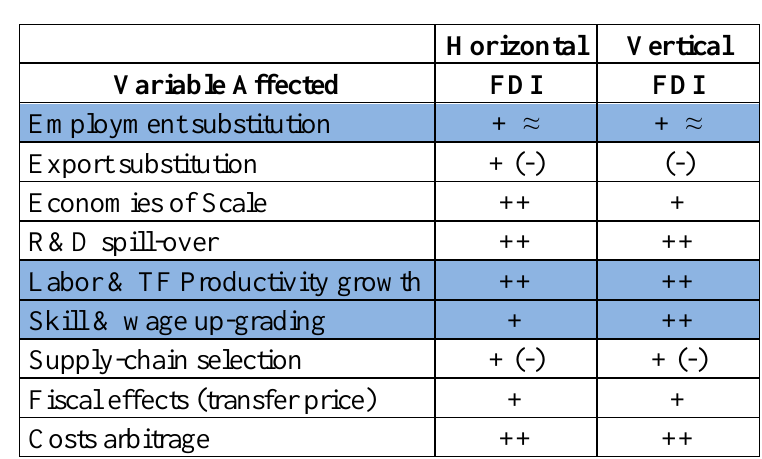
Figure 1: Domestic Effects of Horizontal and Vertical FDI.